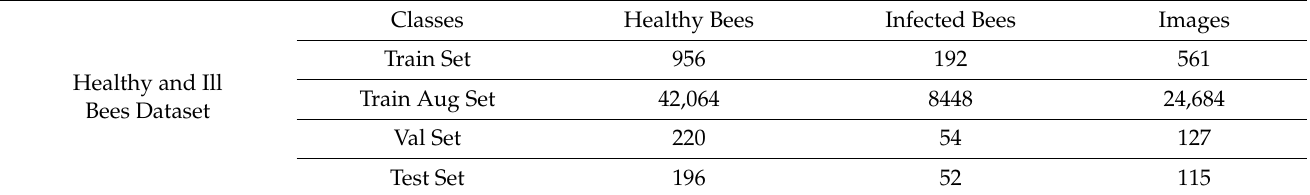
Table 3. The table shows the number of annotated objects of given classes of the Healthy and Infected bees dataset.